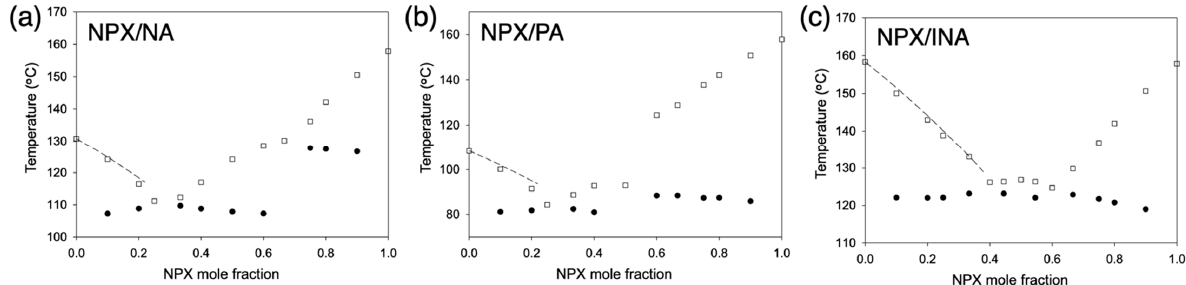
Figure 2. Melting diagrams of ( a ) NPX/NA, ( b ) NPX/PA, and ( c ) NPX/INA mixtures (differential scanning calorimeter (DSC) heating rate 10 °C/min). Dashed lines indicate ideal behaviors calculated with the van’t Hoff equation; empty squares indicate liquidus temperatures; filled circles indicate solidus temperatures.